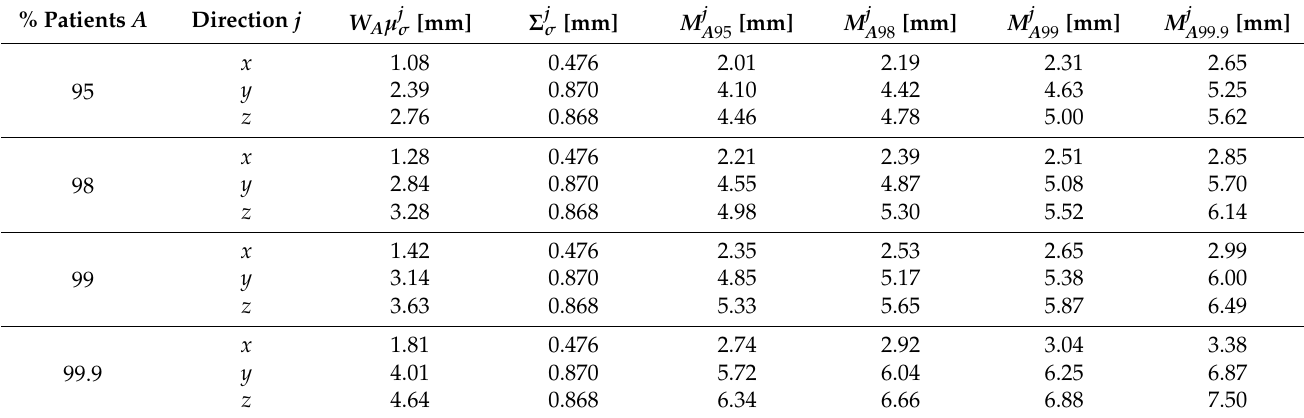
Table 7. Safety margins using the time length intervals I = 300